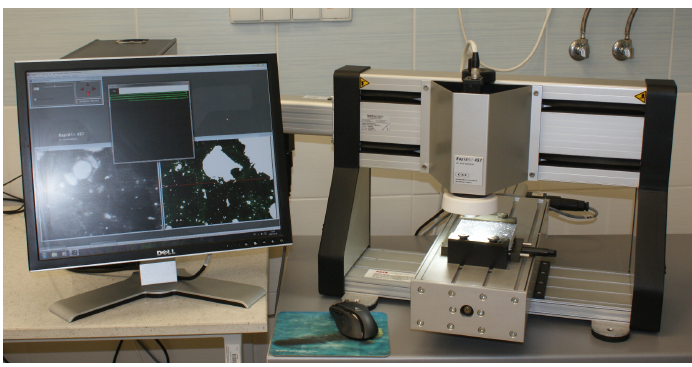
Figure 3. RapidAir 457 device to analyze the pore characteristics